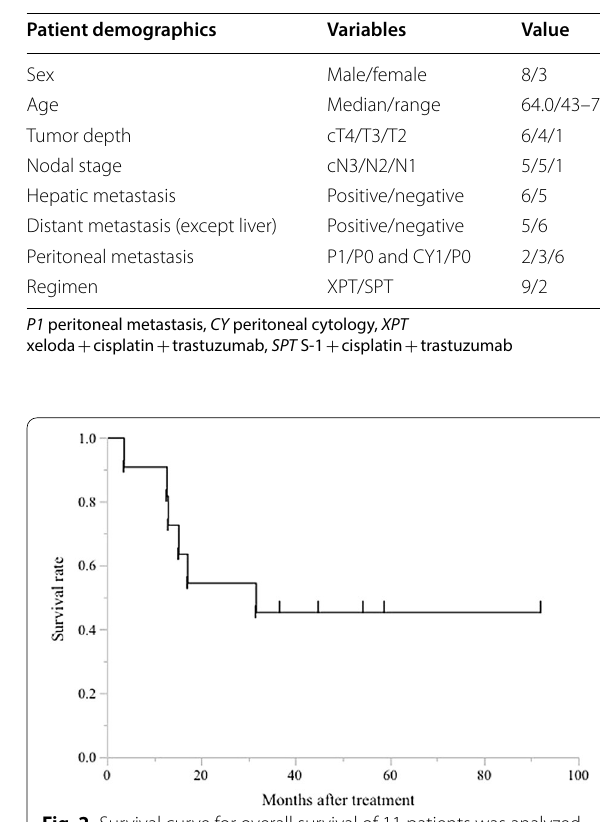
Table 1 Patient characteristics